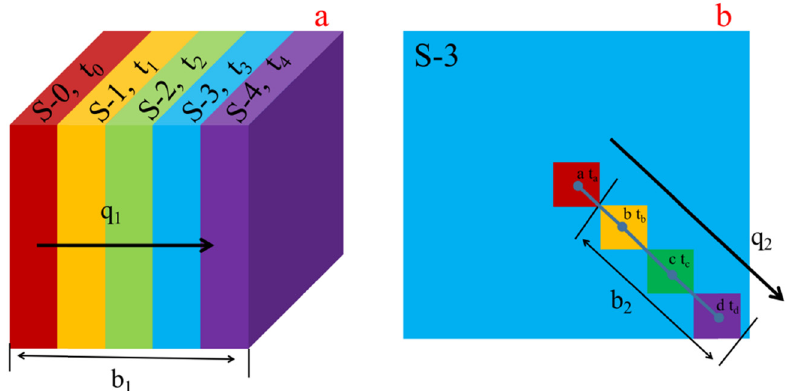
Figure 3: Schematic diagram of the parameters of PP composites: ( a ) di ff erent isothermal planes and ( b ) di ff erent regions of the same isothermal plane.